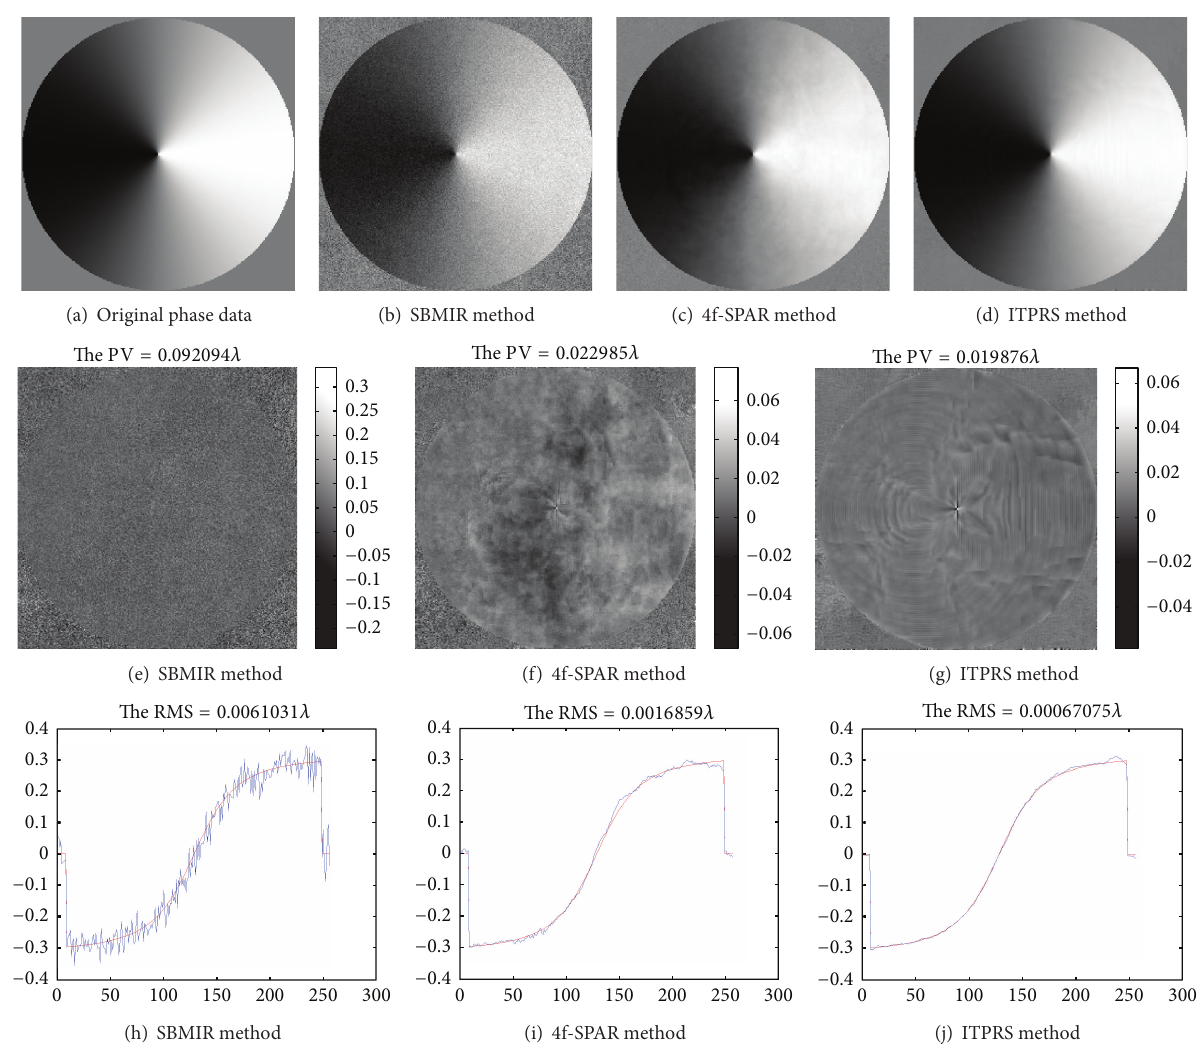
Figure 4: Results of phase retrieval in different methods: the first row (a) is the original phase data and (b)–(d) are the reconstructed phase of wave field; the second row (e)–(g) is the residuals between the original phase data (a) and the reconstructed phase data; the last row (h)–(j) is a random line of phase data between the reconstructed (blue) and original (red) phase